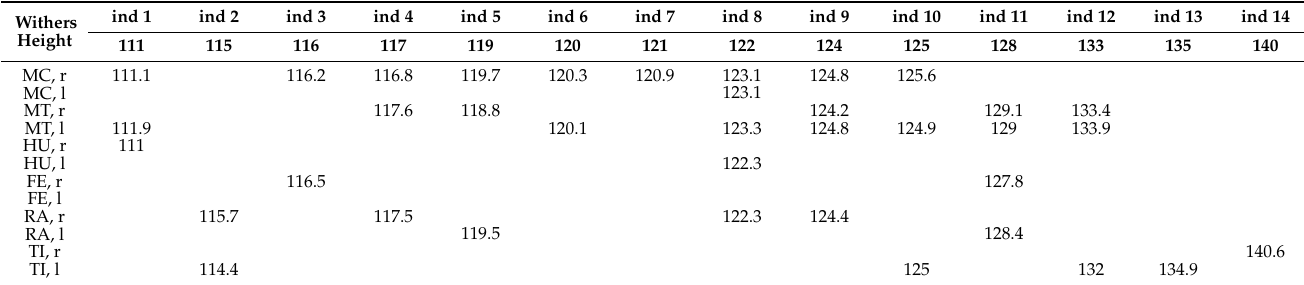
Table 6. Cattle withers heights (in cm) calculated on the basis of the length of several skeletal elements from the Vilauba pit (MC = metacarpus, MT = metatarsus, HU = humerus, FE = femur, RA = radius, TI = tibia, r = right, l = left). Withers Height